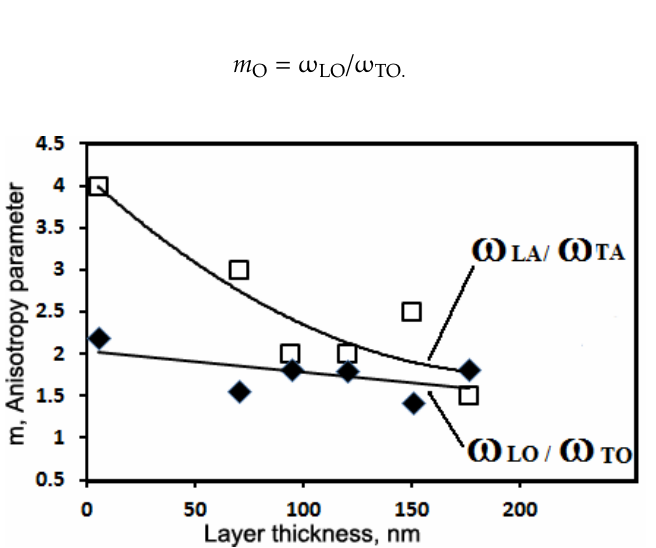
Figure 8. The dependence of phonon propagation anisotropy parameters ( m A , m O ) on Al 2 O 3 layer thickness.